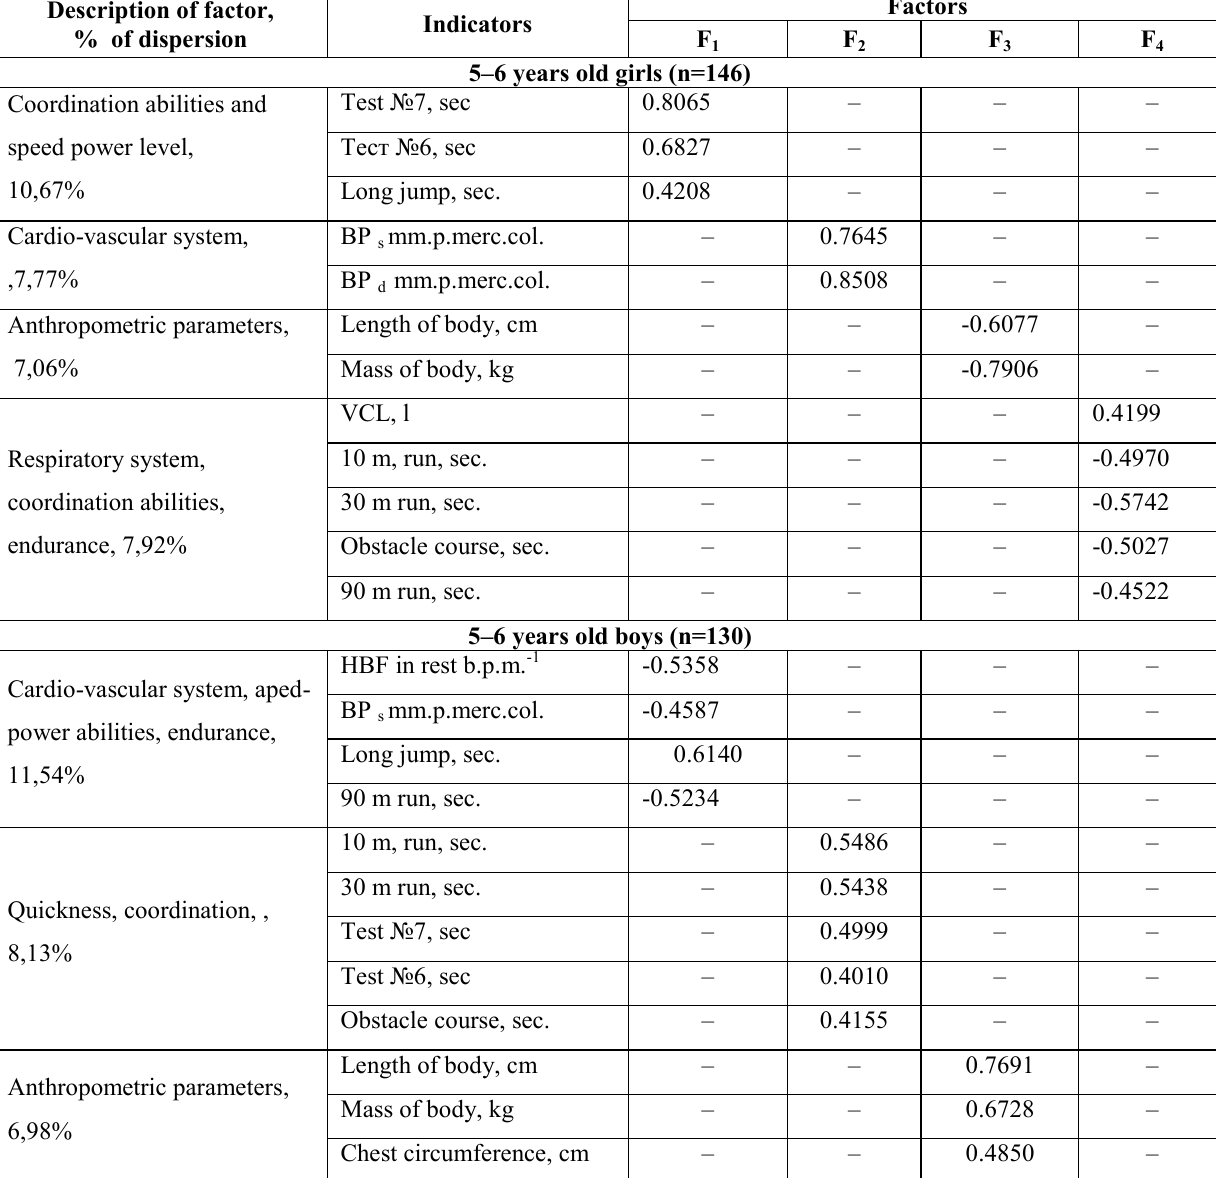
Factor analysis of physical condition and motion functioning of 5-6 years old children (n=276) Description of